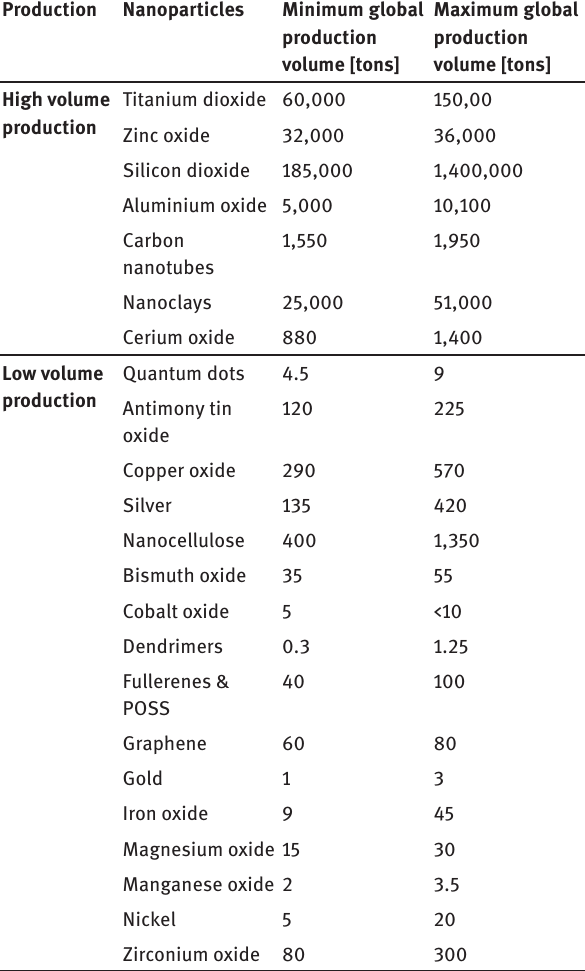
Table 1: Market for nanomaterials - global production in 2014 [3].